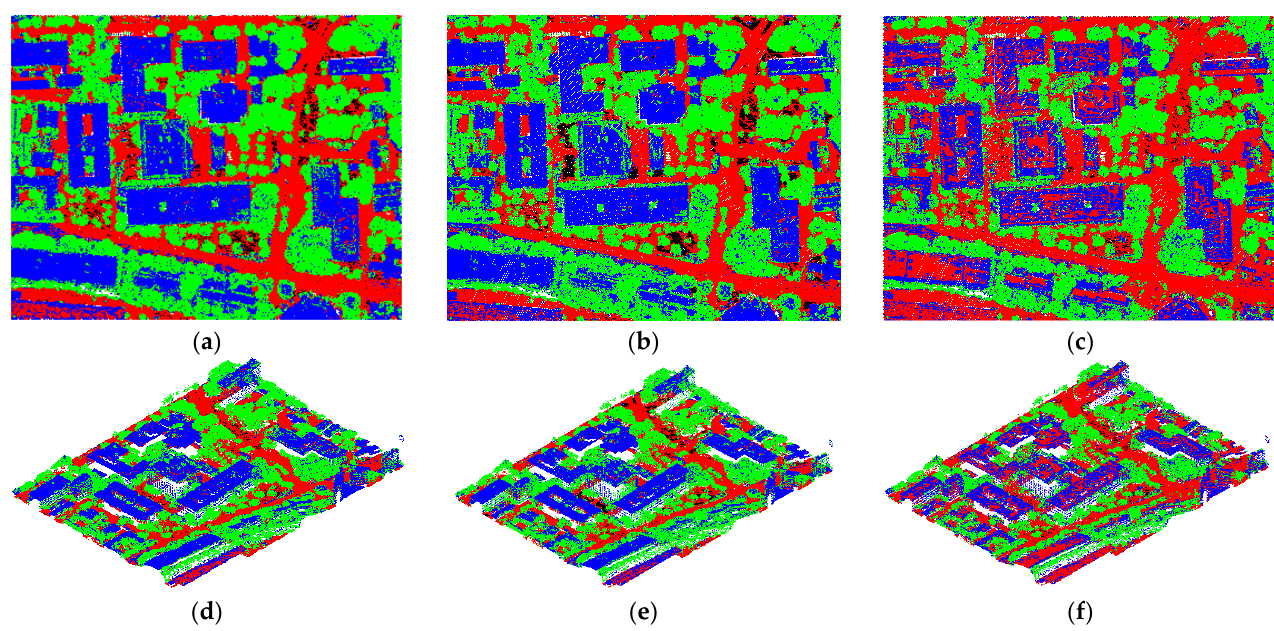
Figure 6. Classification effect of different models in training area A3: ( a , d ) are the classification results of the RF model from a top and side view, respectively; ( b , e ) are the classification results of the DT model from a top and side view, respectively; ( c , f ) are the classification results of the SVM model from a top and side view, respectively.